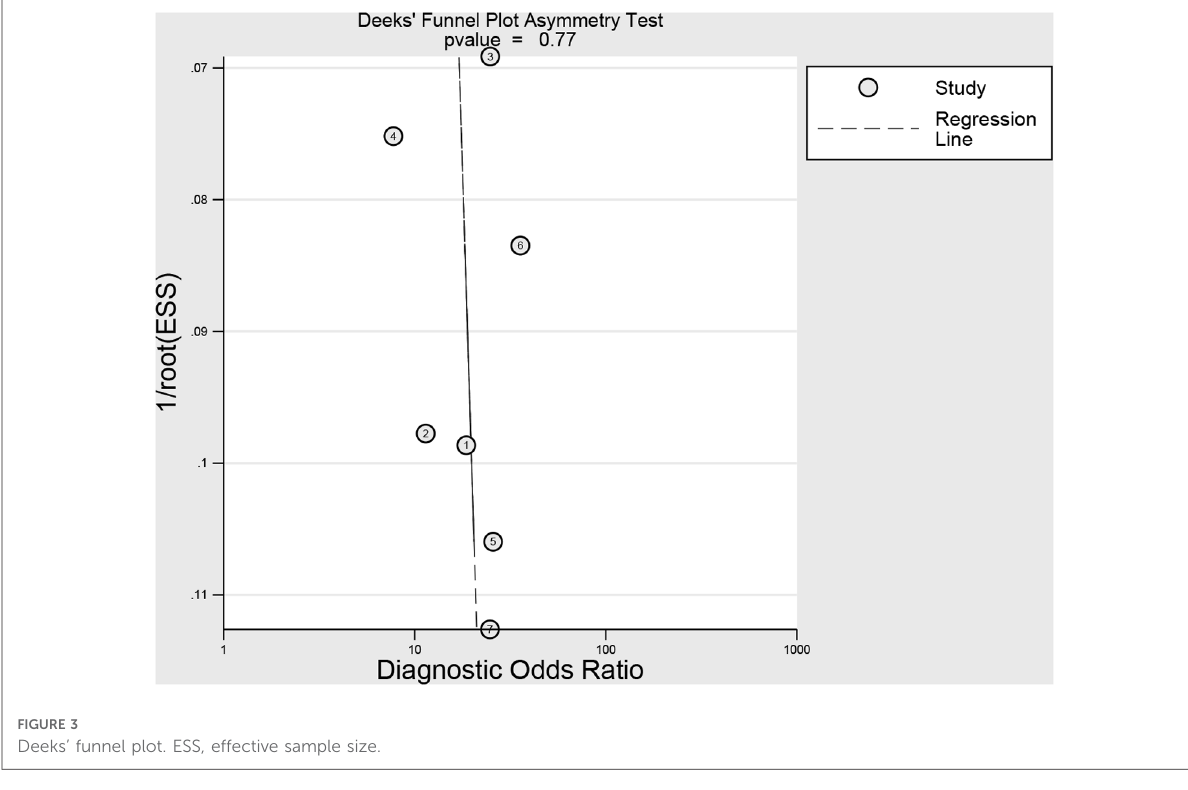
FIGURE 3 Deeks ’ funnel plot. ESS, effective sample size.